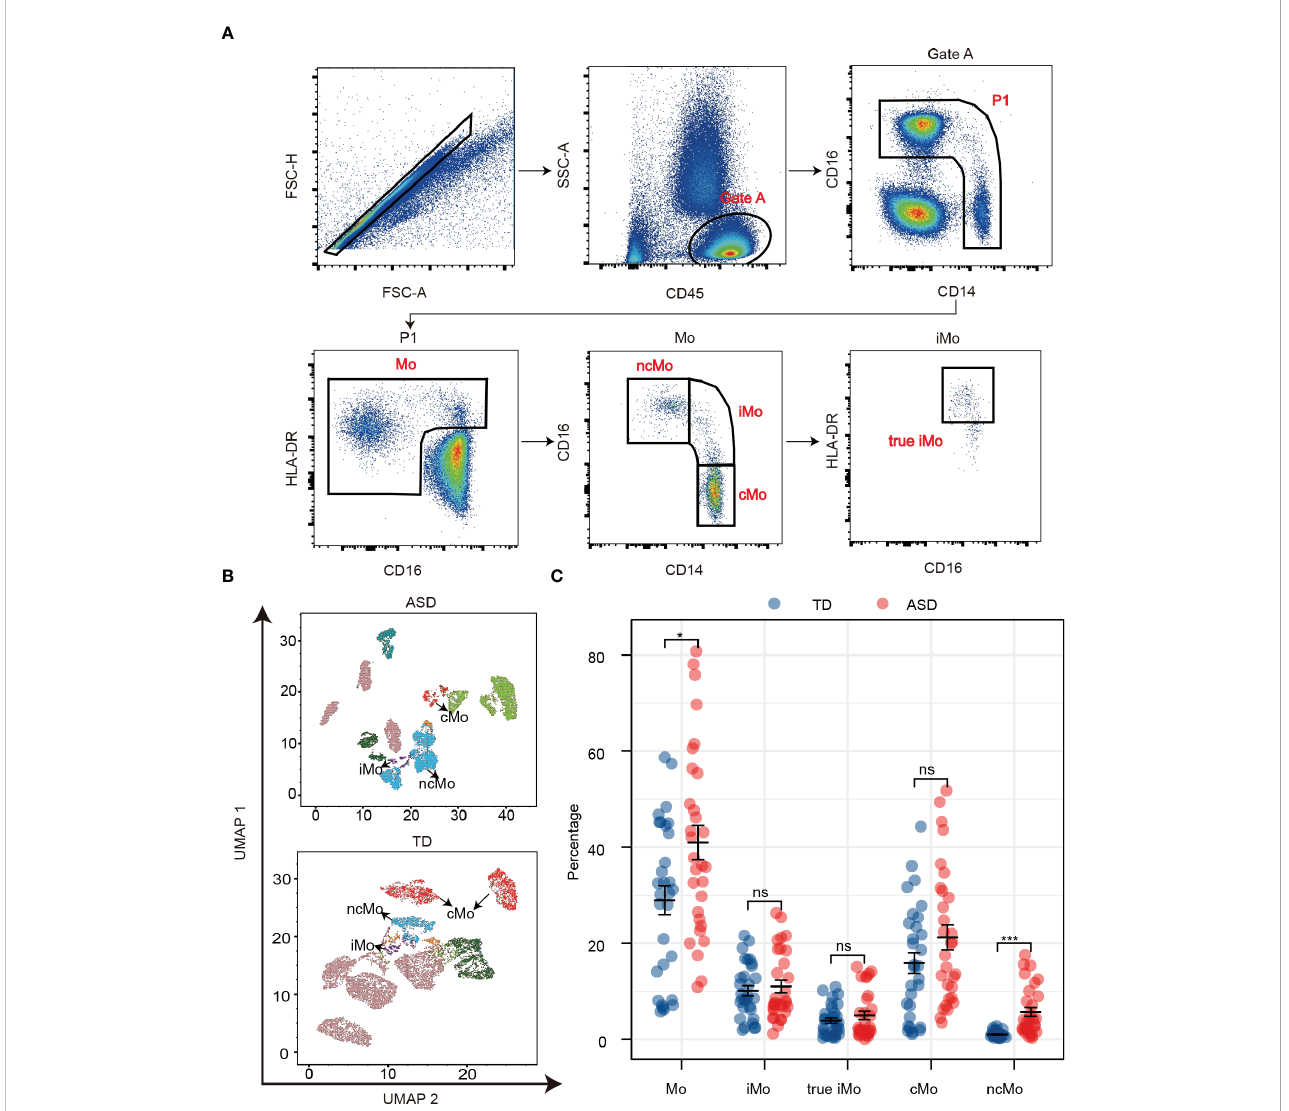
FIGURE 5 The expression of the monocyte phenotype. (A) Monocytes were typed using fl ow cytometry. (B) UMAP for monocytes and monocyte subtypes in children with ASD and TDs. (C) The percentage of monocytes and subtypes in dot plots. * p < 0.05; *** p < 0.001. Mo, monocyte; iMo, intermediate monocyte; cMo, classical monocyte; ncMo, nonclassical monocyte; ns, not signi fi